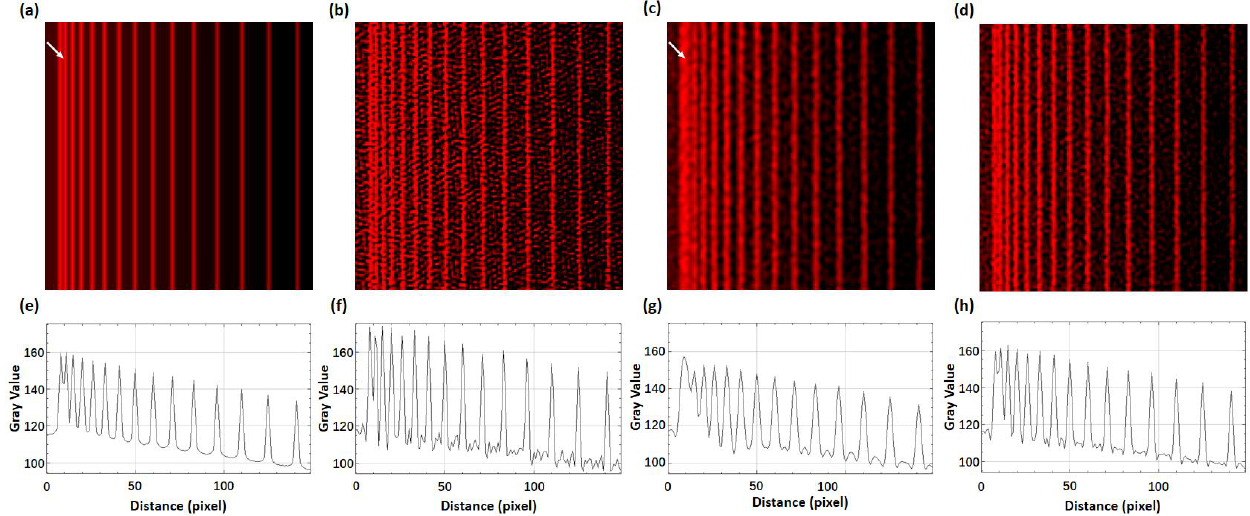
Figure 4. Performance comparison of the noise-corrected SIM reconstruction algorithm with differ- ent regularized constraints. ( a ) Ground truth image. ( b ) The SR image reconstructed by the noise- corrected algorithm with a nonnegativity regularized constraint. ( c ) The SR image reconstructed by the noise-corrected algorithm with a high-frequency suppression regularized constraint. ( d ) The SR image reconstructed by the noise-corrected algorithm with the Tikhonov regularized constraint. ( e ) The horizontal profile averaged along the vertical direction of ( a ). ( f ) The horizontal profile averaged along the vertical direction of ( b ). ( g ) The horizontal profile averaged along the vertical direction of ( c ). ( h ) The horizontal profile averaged along the vertical direction of ( d ).